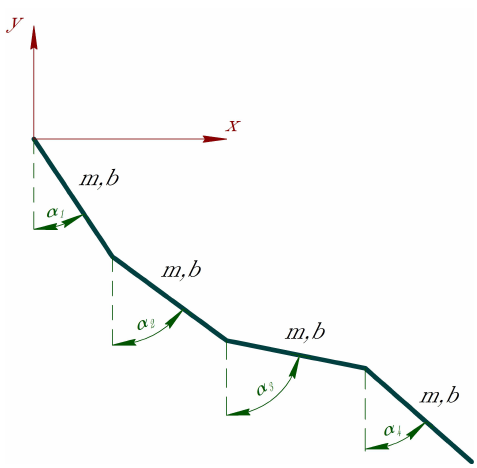
Figure 3. The discrete model of n